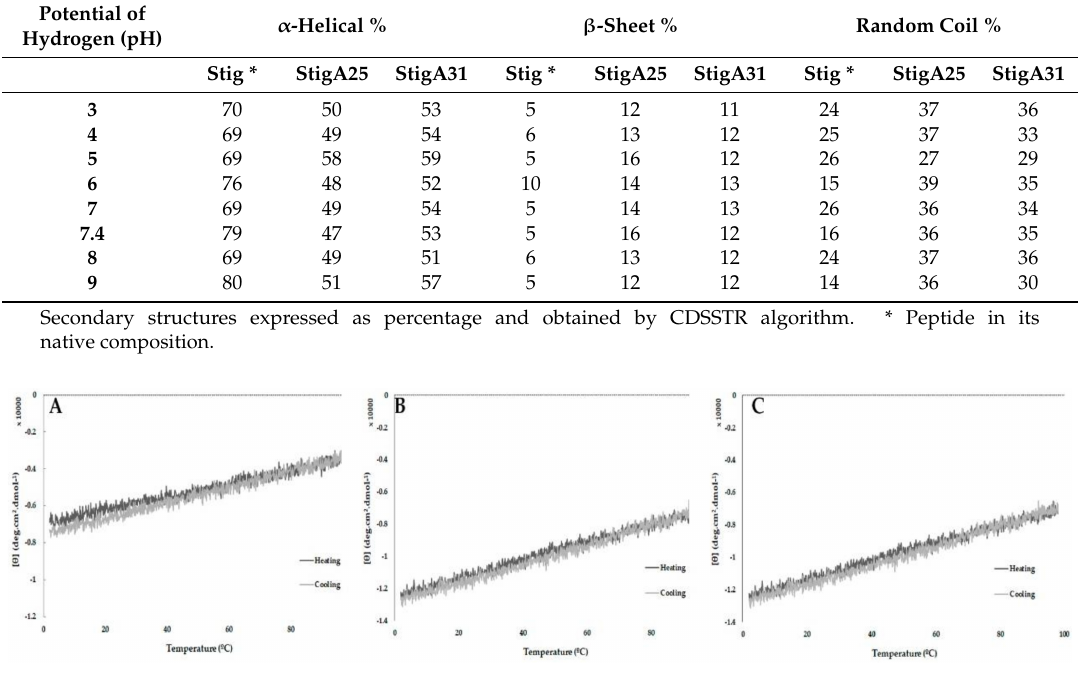
Figure 7. Thermal stability, based on secondary structure evaluation by circular dichroism, of Stigmurin ( A ), StigA25 ( B ), and StigA31 ( C ). CD analyses were carried out in 20 mM SDS with temperatures